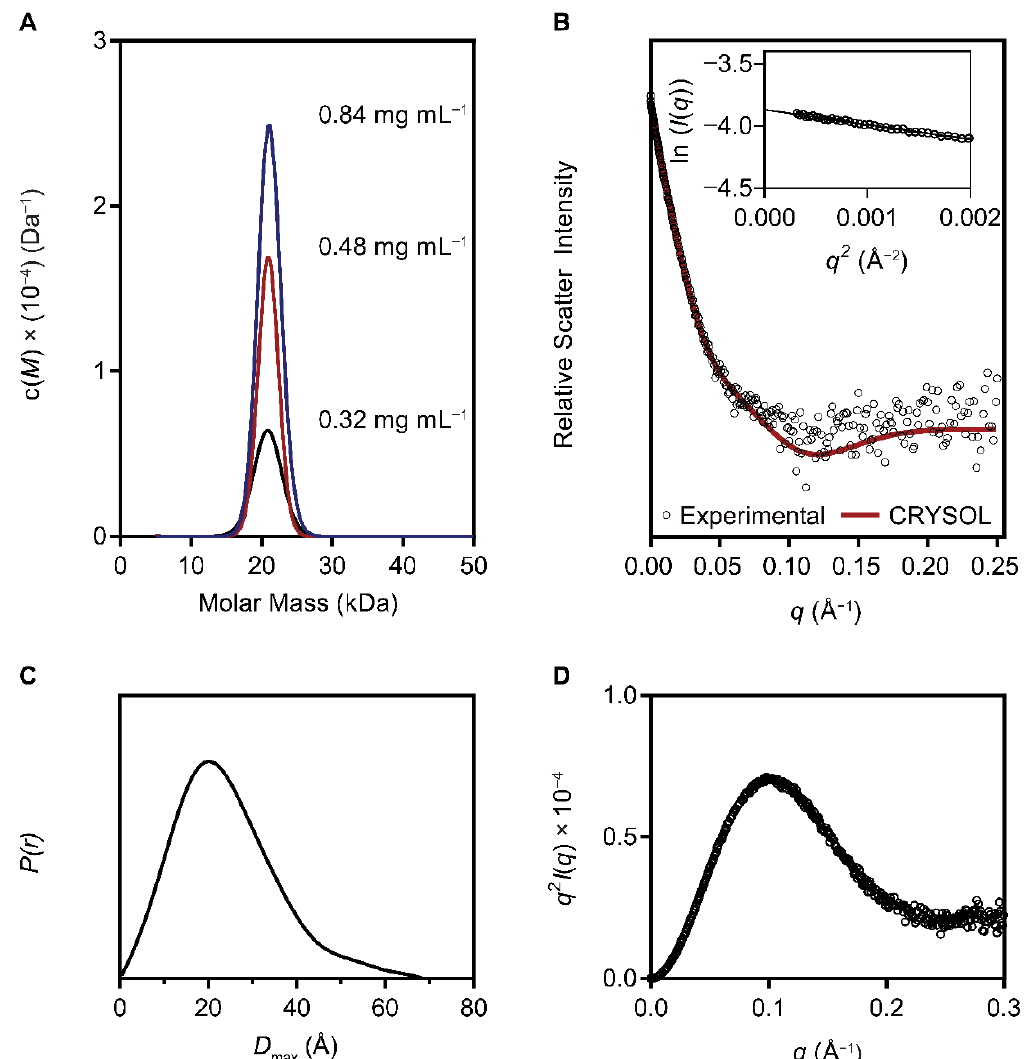
Figure 4. Solution structure of LysF1. ( A ) Sedimentation velocity profile of LysF1 displays a single peak at 20.2 kDa when fit to a continuous molar mass distribution model. This correlates to the molecular weight of a monomeric LysF1. ( B ) The biological relevance of the crystal structure is confirmed by a comparison of theoretical scattering of the LysF1 crystal structure to experimentally determined LysF1 having high similarity. The insert shows the linearity of the low- q range, indicative of high-quality data. ( C ) The pairwise distance distribution P (r) function determined the maximum interparticle distance was 68.39 Å . ( D ) Kratky plot displays a mostly bell-shaped profile, which shows the protein is folded. Deviation from the baseline suggests some protein flexibility.